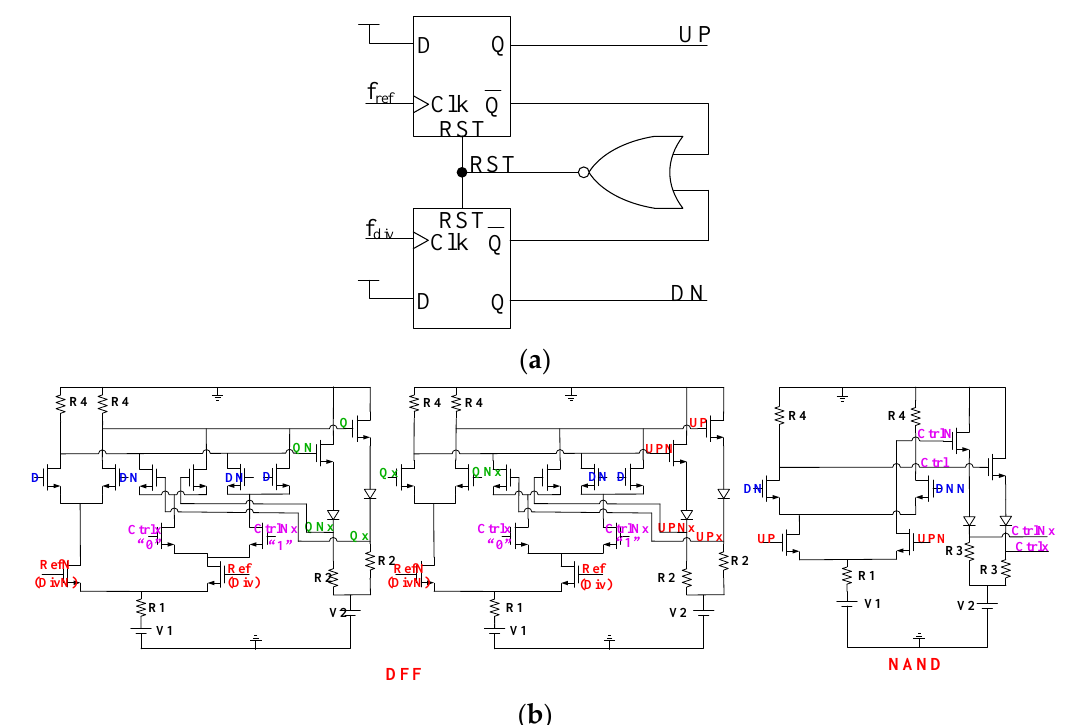
Figure 2. The structure of PFD: ( a ) the architecture of PFD; ( b ) the structure of PFD.